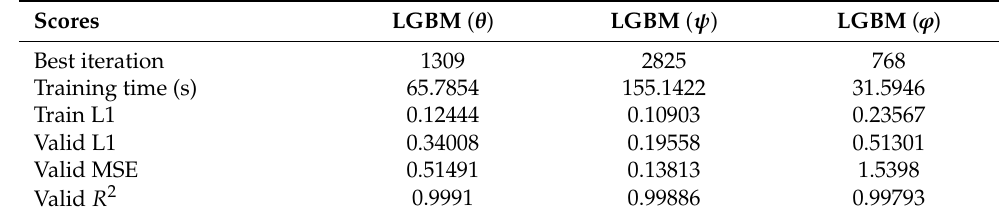
Figure 13. Loss changes in LightGBM training process. ( a – c ) show the training process when LightGBM fits pitch, yaw, and roll angles, respectively. Table 2. Training results of LightGBM model for dual-view